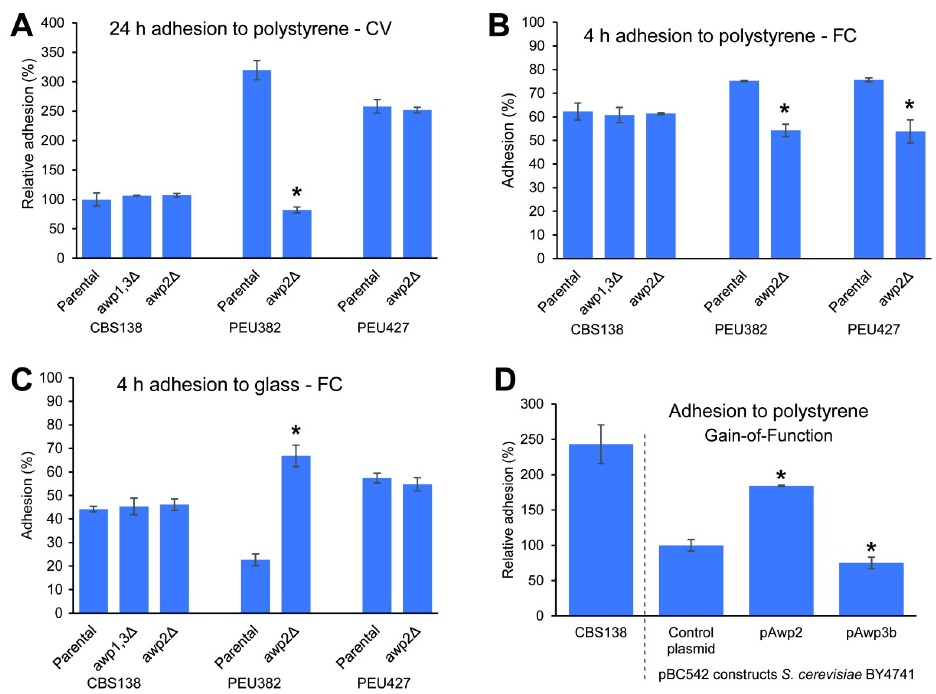
Fig 2. Awp2 mediates adhesion to plastic. (A) Adhesion to polystyrene after 24 h measured by Crystal violet (CV) staining. (B) Adhesion to polystyrene after 4 h measured by FC. (C) Adhesion to glass being measured after 4 h by flow cytometry (FC). Data in (A) are normalized to CBS138. AWP2 was deleted in three genetic backgrounds: reference strain CBS138, and hyperadhesive strains PEU382 and PEU427. AWP1 and AWP3 were deleted only in CBS138 as the corresponding proteins have not been identified in the hyperadhesive strains. (D) Adhesion to polystyrene after 24 h of gain-of-function mutants in S . cerevisiae , normalized to parental strain BY4741. Asterisks indicate significant differences of mutants compared to their parental strains (A) and (B) or the empty plasmid control (D).